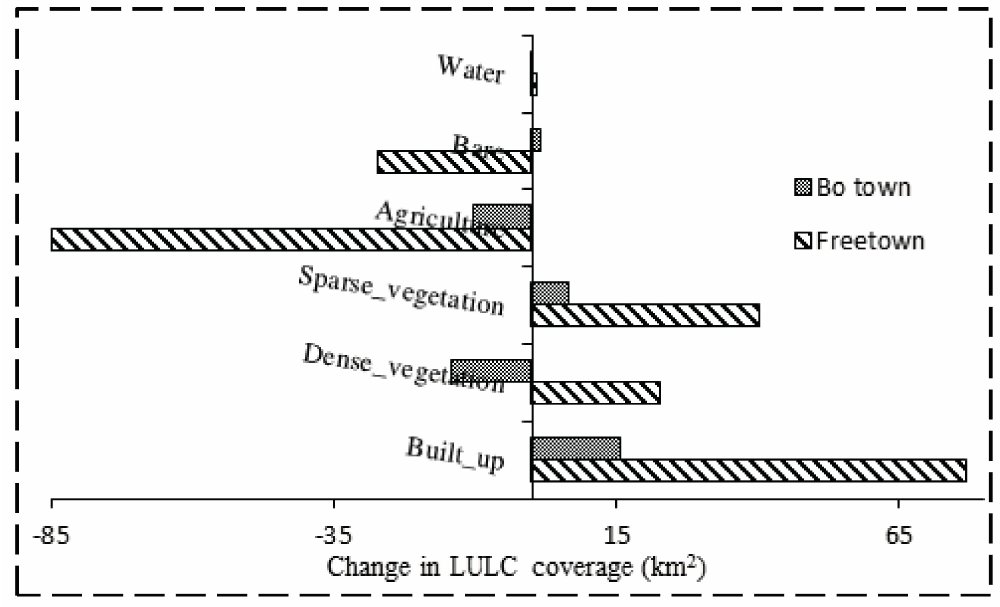
Figure 3. Urban growth induced LULC changes in Freetown and Bo town (1998 to 2015).